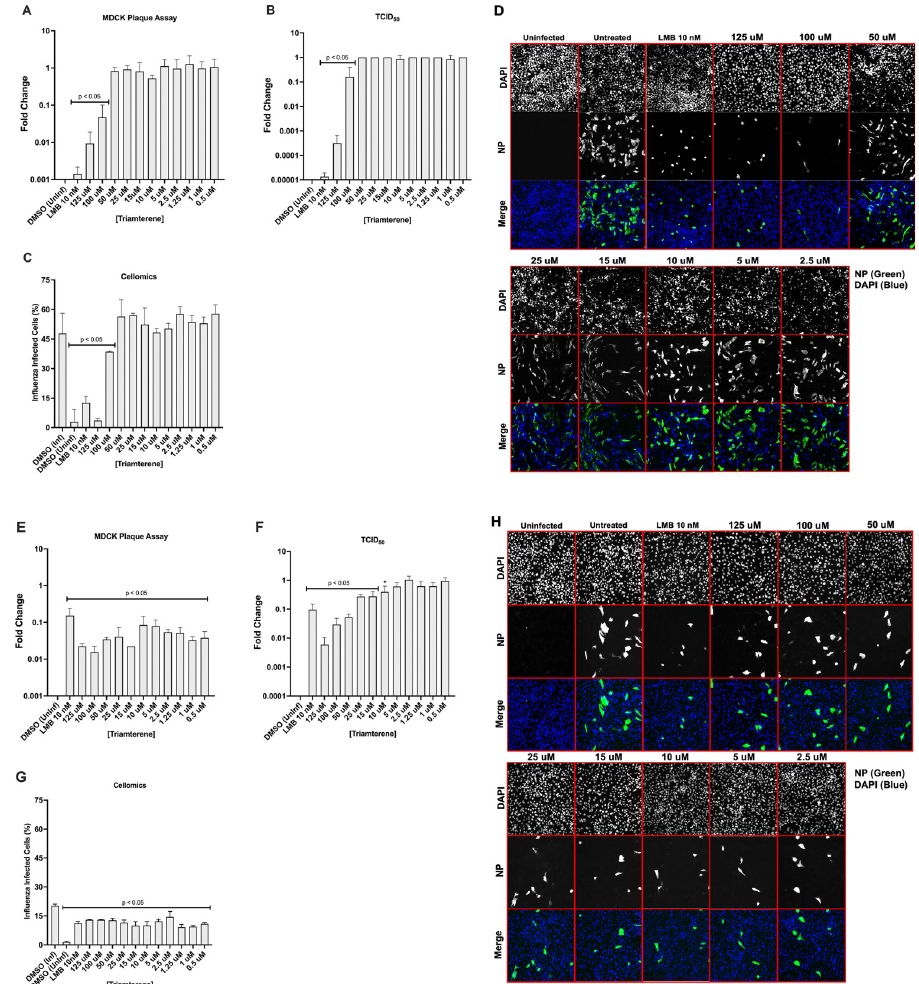
Fig 5. Pretreatment with Triamterene reduces A/CA/04/09 and B/Yamagata/16/1988 replication. Calu-3 cells were pretreated with Triamterene for 24h, or LMB for 2h before infection with either A/CA/04/09 (MOI = 0.1) (A-D) or B/ Yamagata/16/1988 (MOI = 0.1) (E-H). At the time of infection, the media was removed and the virus was added with drug replenishment. The infection was incubated for 24h. Post-infection, supernatants were collected and evaluated by plaque assay (A, E) and TCID 50 assay with HA endpoint (B, F). Fixed Calu-3 cells were immunostained for NP (C, D) or B/Yamagata/16/1988 antigen (G, H) and with DAPI for Cellomics analysis and imaging. Data show means ± standard errors of the means for two independent experiments performed in triplicate. Statistically significant differences from DMSO-treated controls were determined by one-way analysis of variance with Dunnett’s multiple- comparison test (p < 0.05) and are indicated on graphs where appropriate. Influenza NP is green; nuclei are